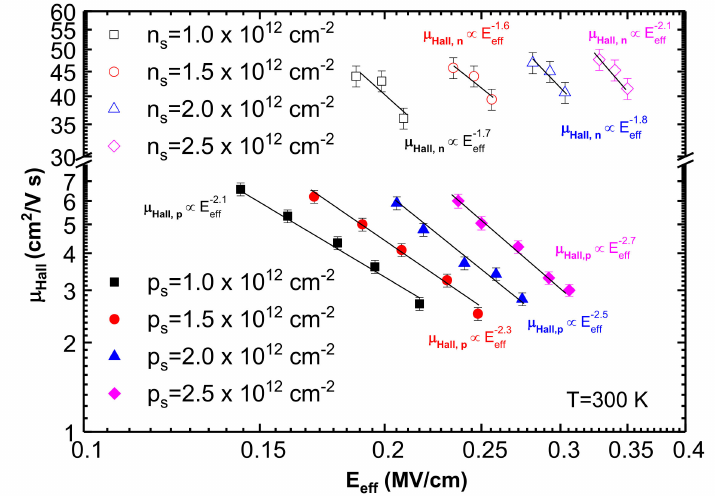
Figure 6. Transverse electric field ( E eff ) dependence of Hall mobility ( µ Hall ) at different body biases ( − 1, − 2, and − 3 V for n-channel and 0, +1, +3, +5, and +7 V for p-channel) at room temperature (27 ◦ C) for different carrier concentrations (1.0 × 10 12 ,1.5 × 10 12 , 2.0 × 10 12 , and 2.5 × 10 12 cm − 2 ), in log–log scale. The different E eff points for a particular curve were obtained from different body biases at a fixed carrier concentration from Figure 5. The average power law that µ Hall follows on E ef f is ( − 1.8 ± 0.2 ) for n-channel MOSFETs and ( − 2.4 ± 0.3 ) for p-channel MOSFETs, providing the power of E ef f for surface roughness scattering for electrons and holes in 4H-SiC MOSFETs. Error bars signify ~5% error estimated based on variation in at least 3